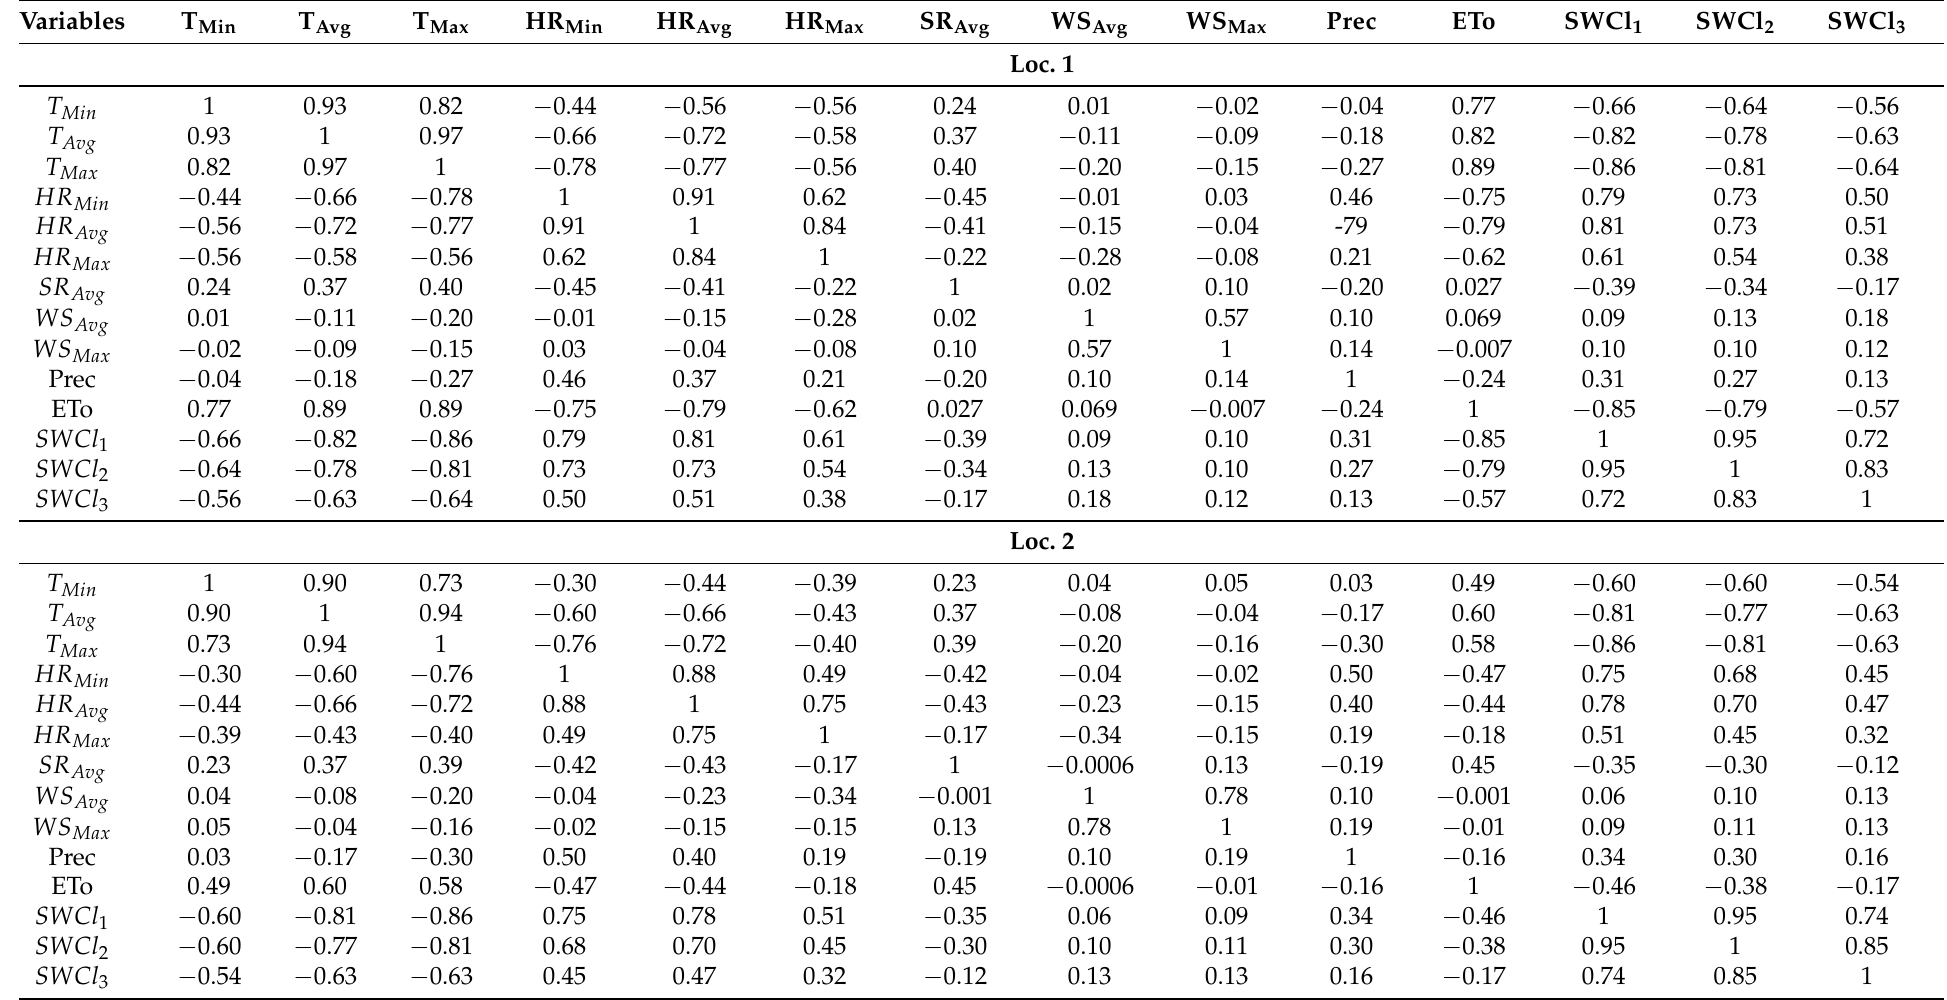
Table A2. Collinear coefficient between parameters in dataset (Loc. 1 and Loc.